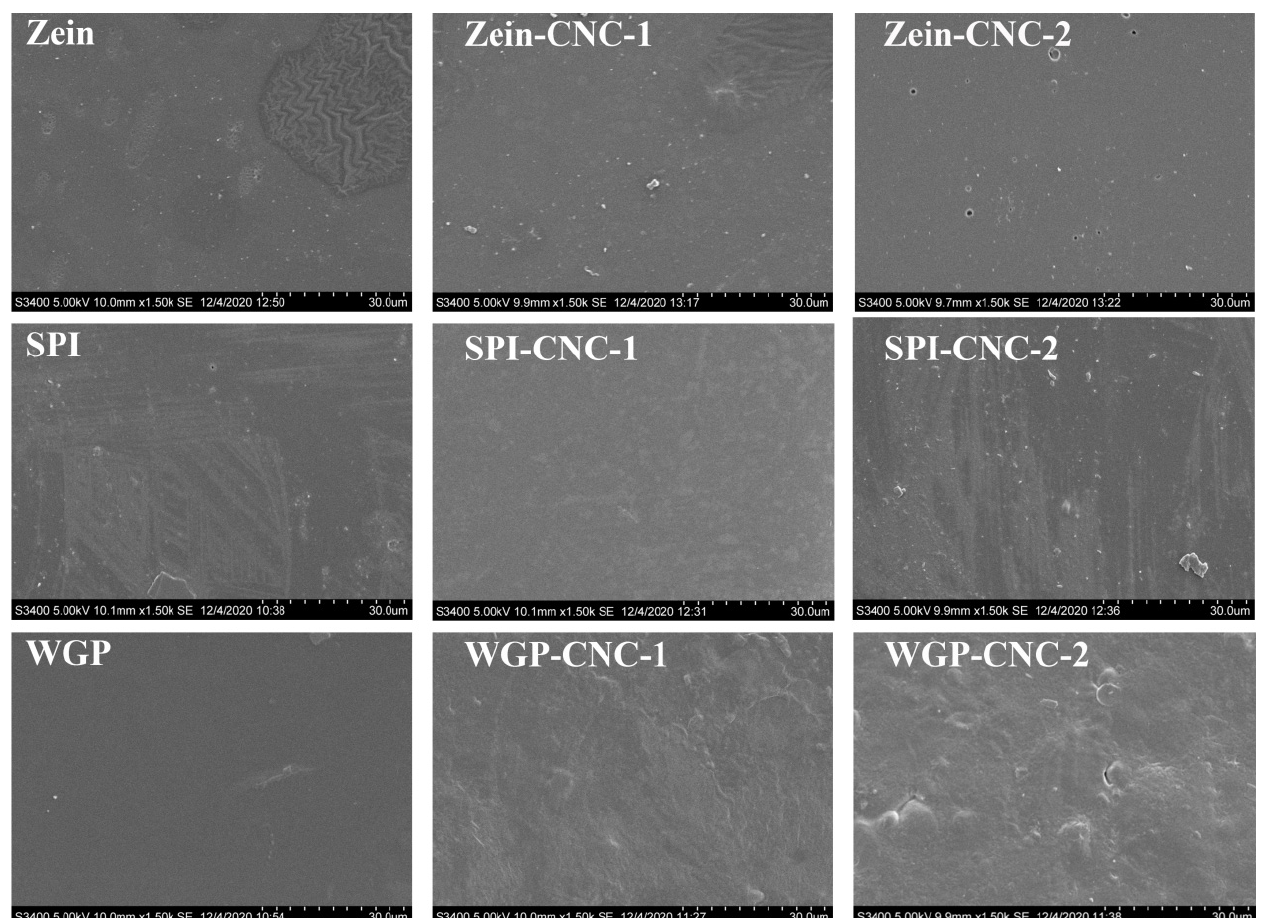
Figure 6. SEM images of rough surface of the Zein/SPI/WGP-based films (magnifications are 1000×).